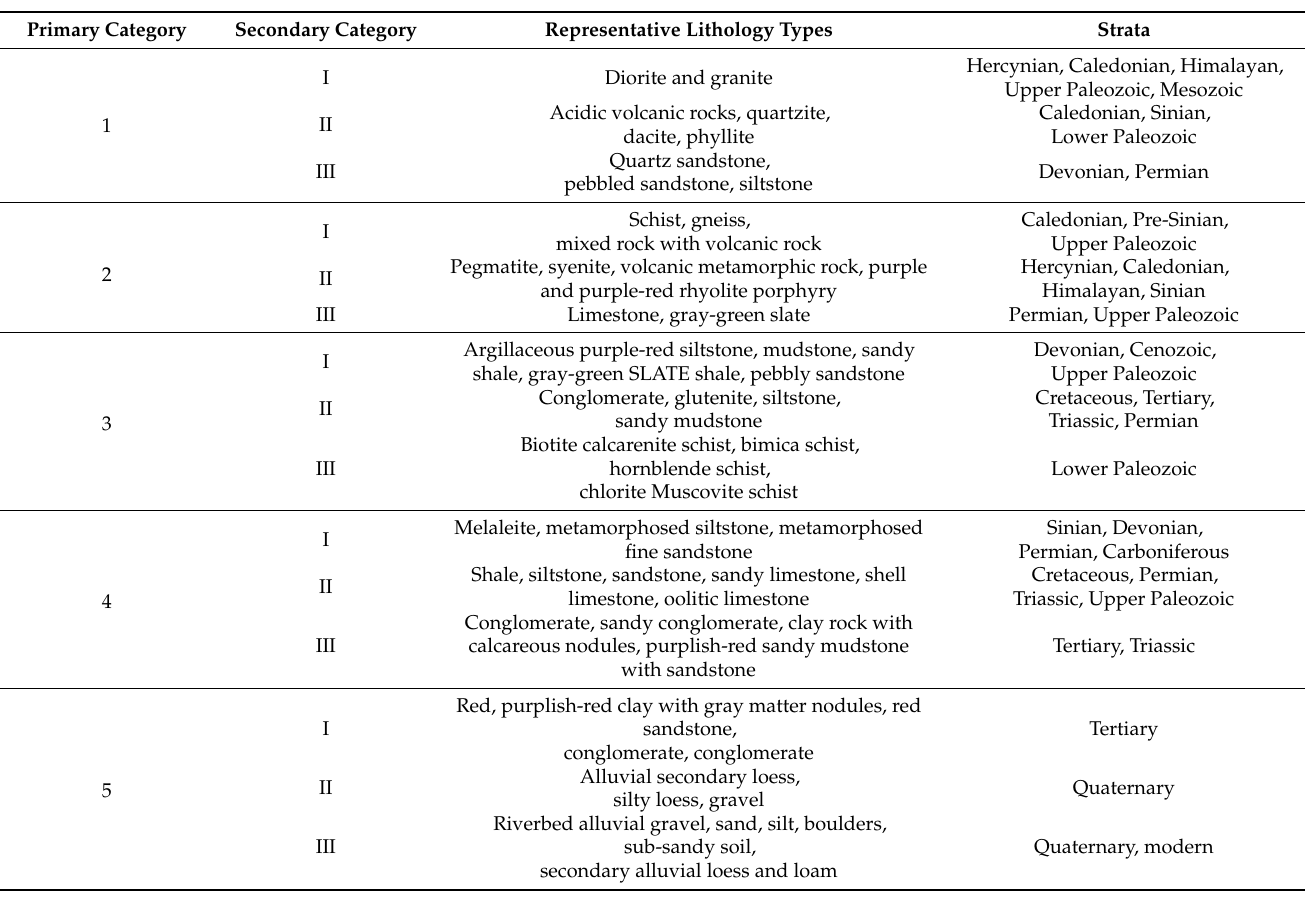
Table 3. Detailed lithology types in the study area. The lithology types are divided into 5 primary categories labeled 1 to 5. Category 1 is marked as the Very Hard (VH) rock group while category 5 is the Very Soft (VS) rock group, each group is further divided with 3 sub-categories labeled I–III with the same sorting